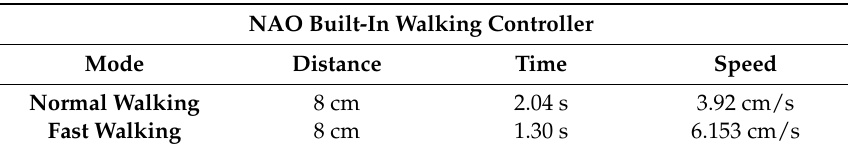
Table 4. NAO’s built-in walking controller.